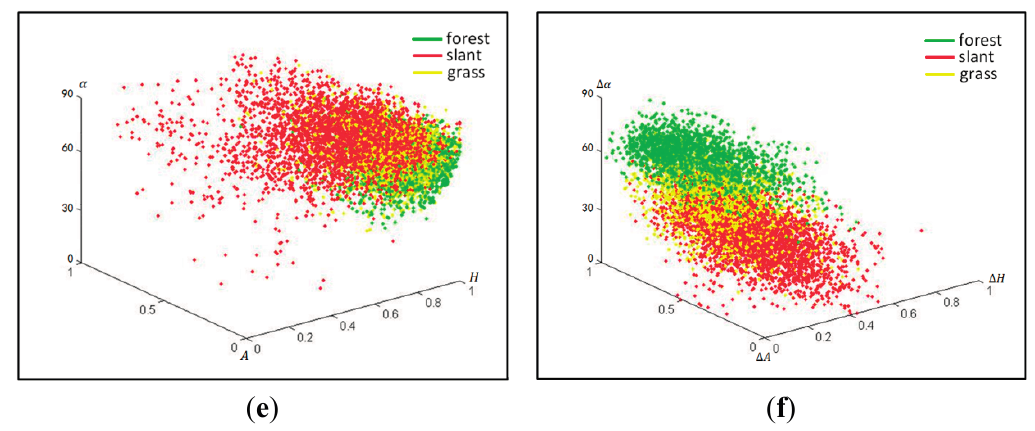
Figure 4. The scatter diagrams of forest, slant-buildings and grassland in feature set 1 and 2. Scattering entropy ( H ), anisotropy ( A ) and scattering angle ( α(cid:3365) ) are decomposed from the PolSAR image. The same Cloude–Pottier decomposition is also conducted on the two sub-aperture images, respectively, and feature set 2, with its elements Δ H , Δ A and α(cid:3365) , is obtained through the differences between H , A and α(cid:3365) of each sub-aperture image, respectively. ( a ) Feature set 1: forest and slant-buildings; ( b ) Feature set 2: forest and slant-buildings; ( c ) Feature set 1: forest and grassland; ( d ) Feature set 2: forest and grassland; ( e ) Feature set 1: forest, grassland and slant-buildings; ( f ) Feature set 2: forest, grassland and